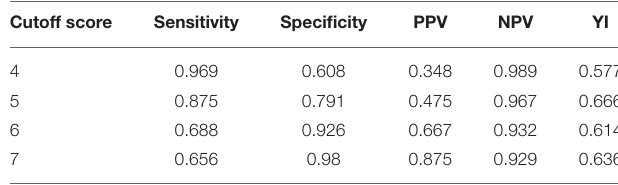
TABLE 3 | ROC and diagnostic efficiency of the APE 2 score for the diagnosis of AE with autoantibodies to cell-surface proteins expressed in neurons. Cutoff